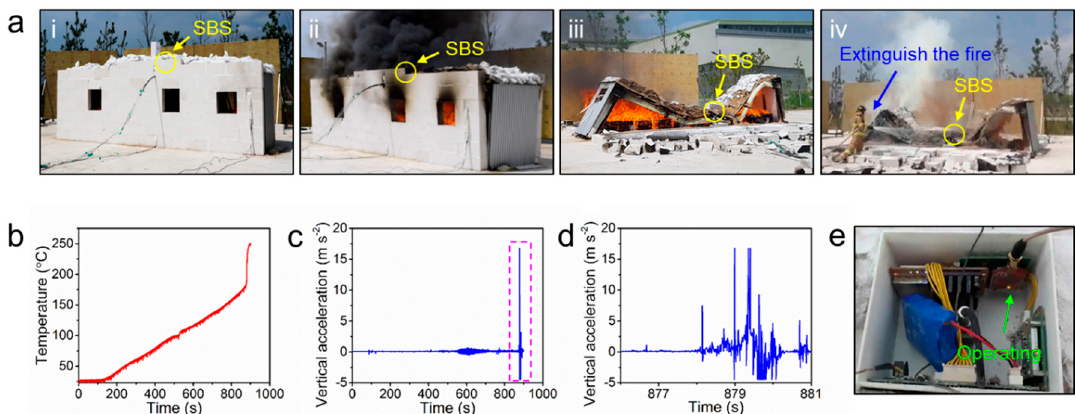
Figure 8. ( a ) Photographs during the testbed experiments; (i) before the fire, (ii) in a fire situation, (iii) after the collapse due to the fire and (iv) extinguishment. Measured values of ( b ) temperature, ( c ) vertical acceleration during the entire testbed experiment and ( d ) at the moment the PEB collapses; ( e ) retrieved sensor module after the test. The sensor module was still operating.